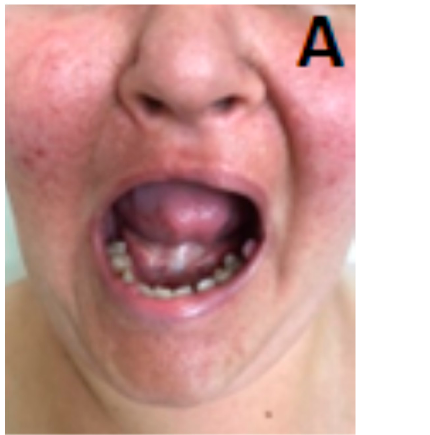
Figure 1. ( A ): Round faces; purplish red facial skin angiomas on the nose, malar and cheekbones; ( B ): lateral view; excess subcutaneous tissue; ( C ) Multiple depigmented macules and papillomatous tumorlets in the neck and thorax.